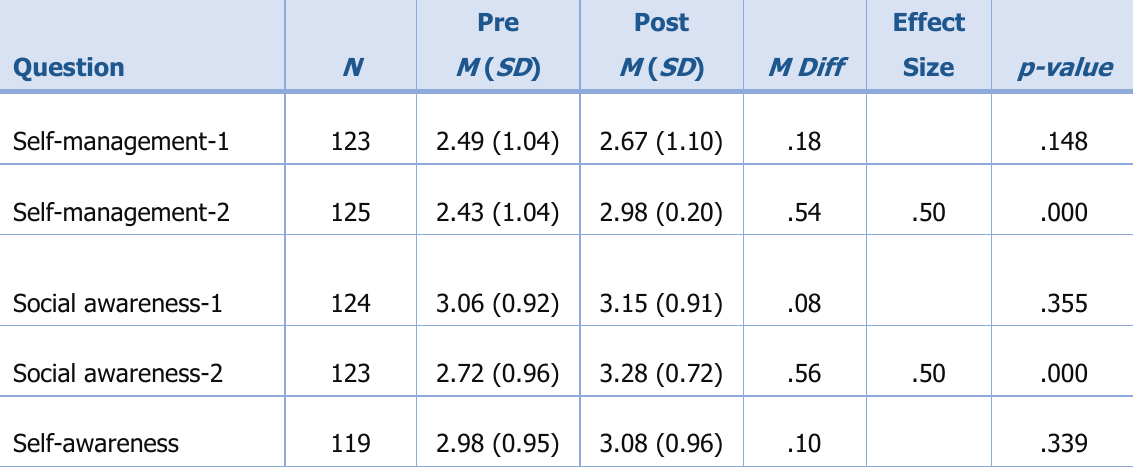
Table 2. Outcomes of Evaluation of SEL Curriculum at